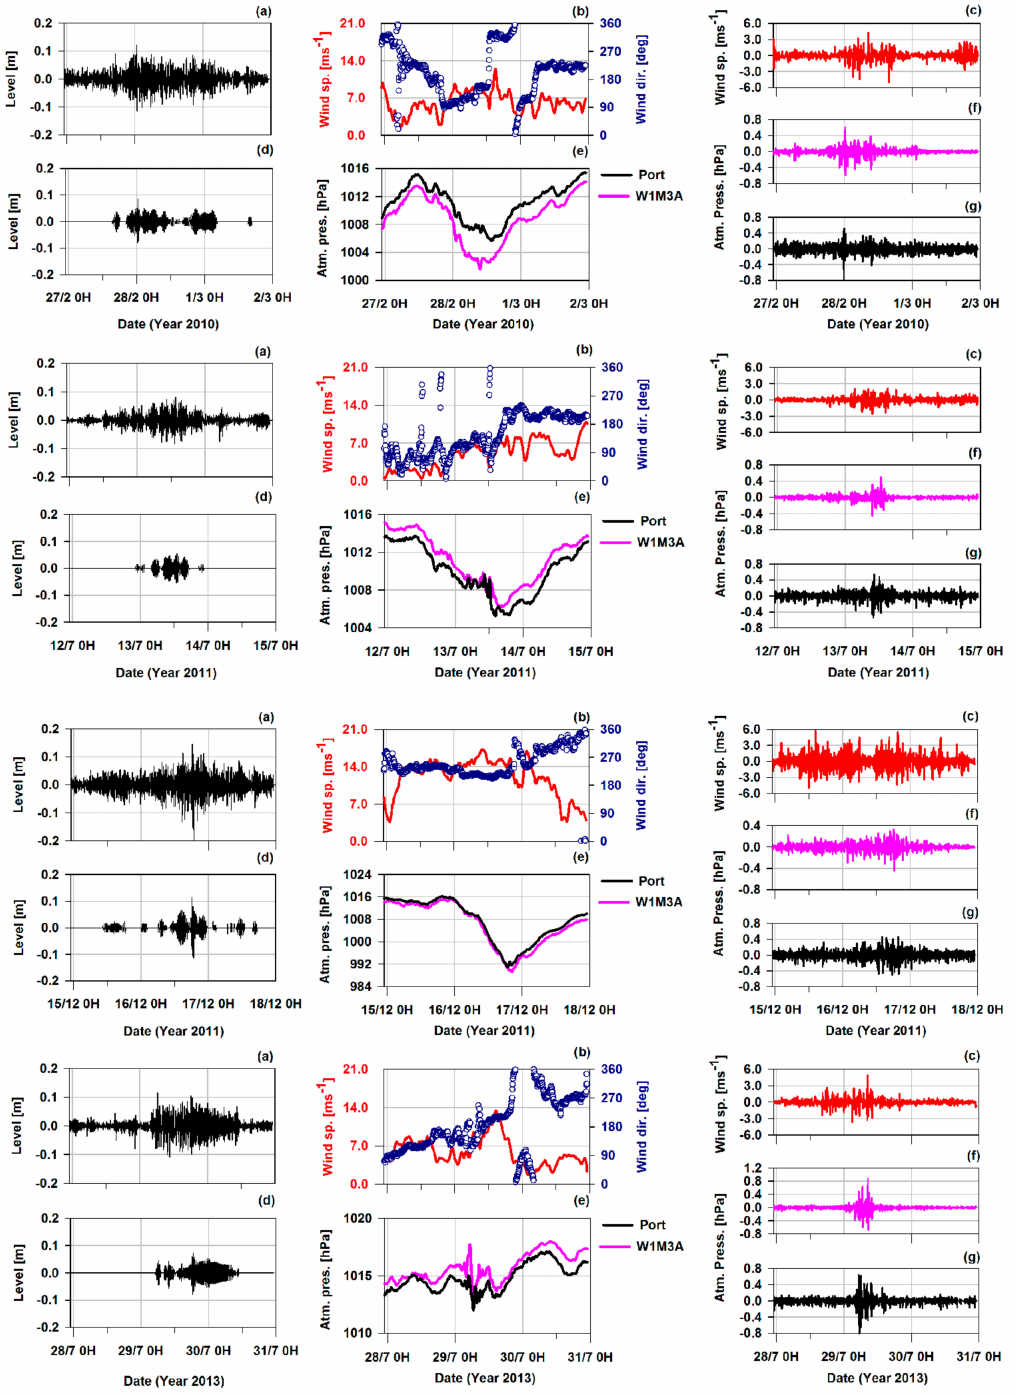
Figure 6. For each selected event, time series of: ( a ) Sea-level residuals; ( b ) wind speed and direction measured by the W1M3A observatory; ( c ) residual of wind speed from the W1M3A observatory; ( d ) wavelet-filtered and reconstructed sea-level residuals; ( e ) atmospheric pressure measured by the W1M3A observatory and in the port of Genoa; ( f ) residual of atmospheric pressure from the W1M3A observatory; ( g ) residual of atmospheric pressure measured in the port of